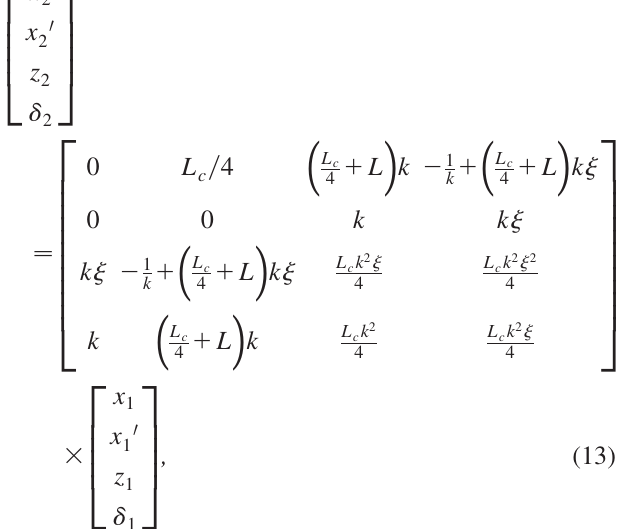
TABLE II. EEX beam line